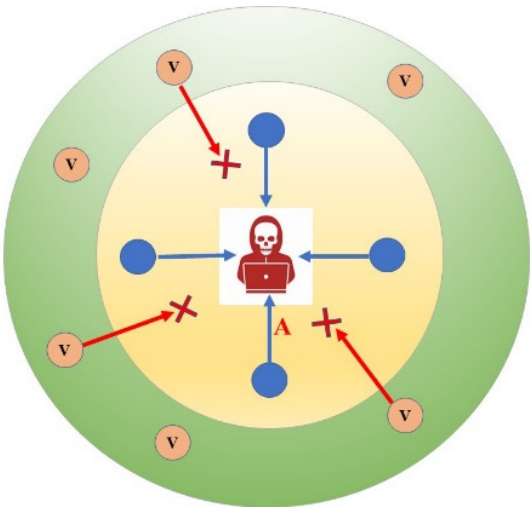
Figure 10. A Hello Flood attack.